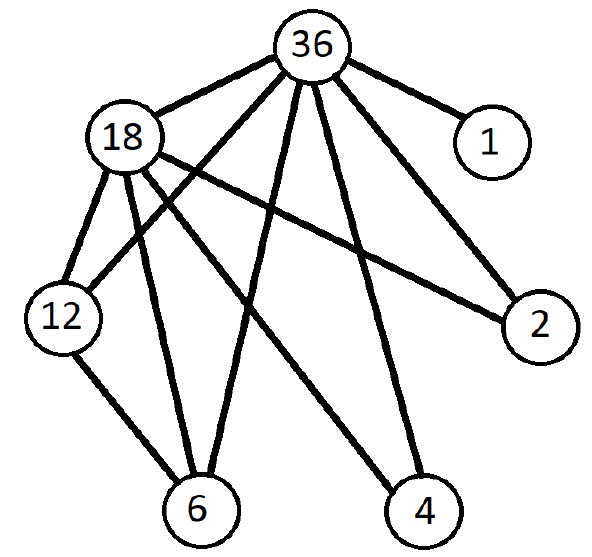
Figure 9. Congruence graph for λ 0 = 36.